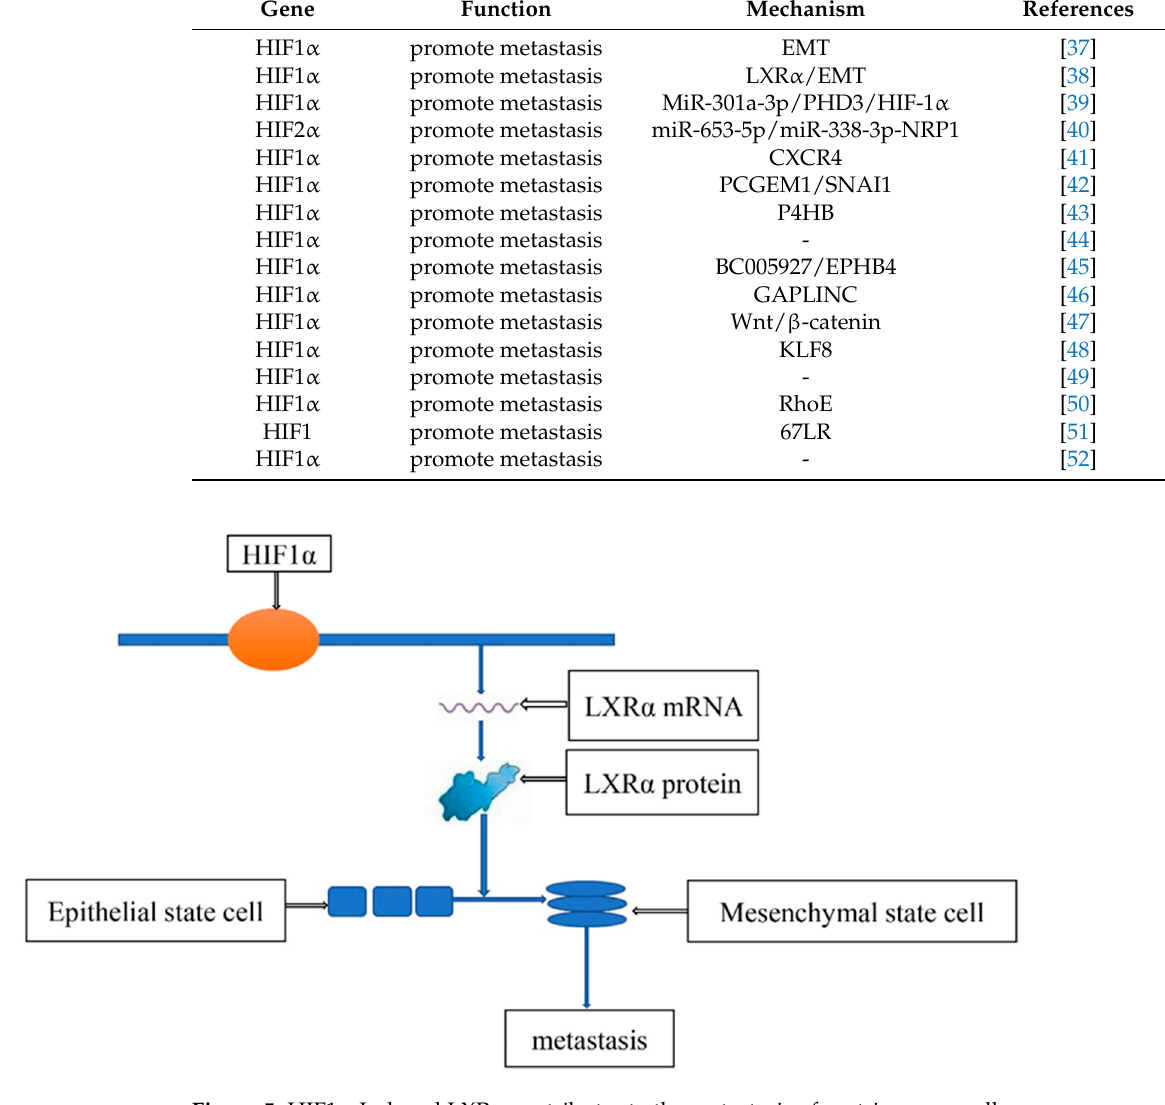
Figure 5. HIF1 α -Induced LXR α contributes to the metastasis of gastric cancer cells.